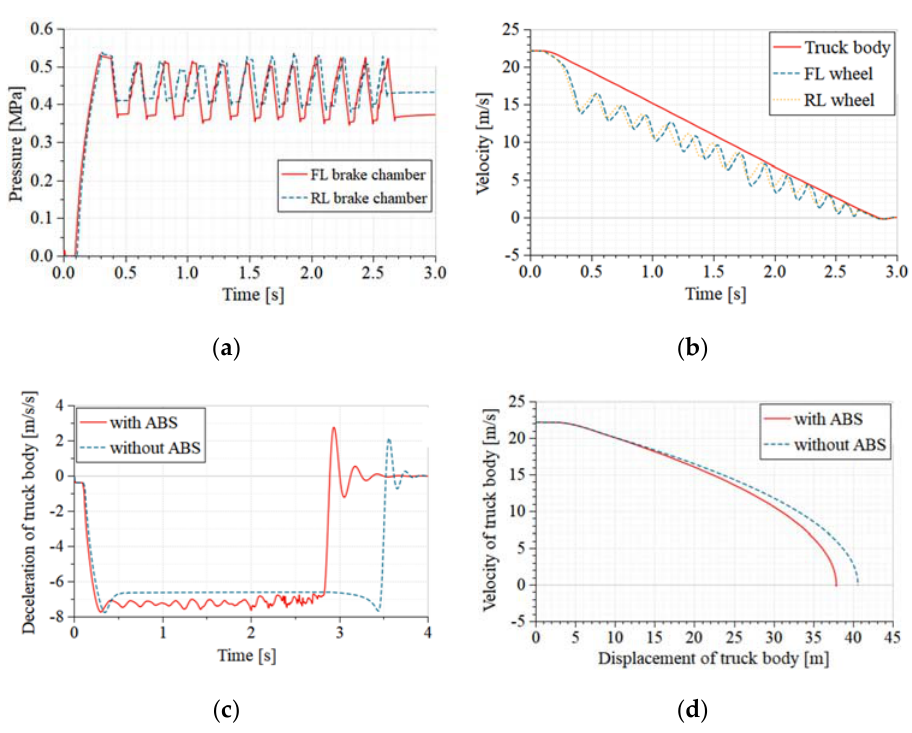
Figure 15. Braking characteristics on the road with the adhesion coe ffi cient 0.8. ( a ) Pressure of brake chamber; ( b ) velocity of truck body and wheels; ( c ) deceleration of truck body with ABS and without ABS; ( d ) velocity-displacement curves of truck body with ABS and without ABS.